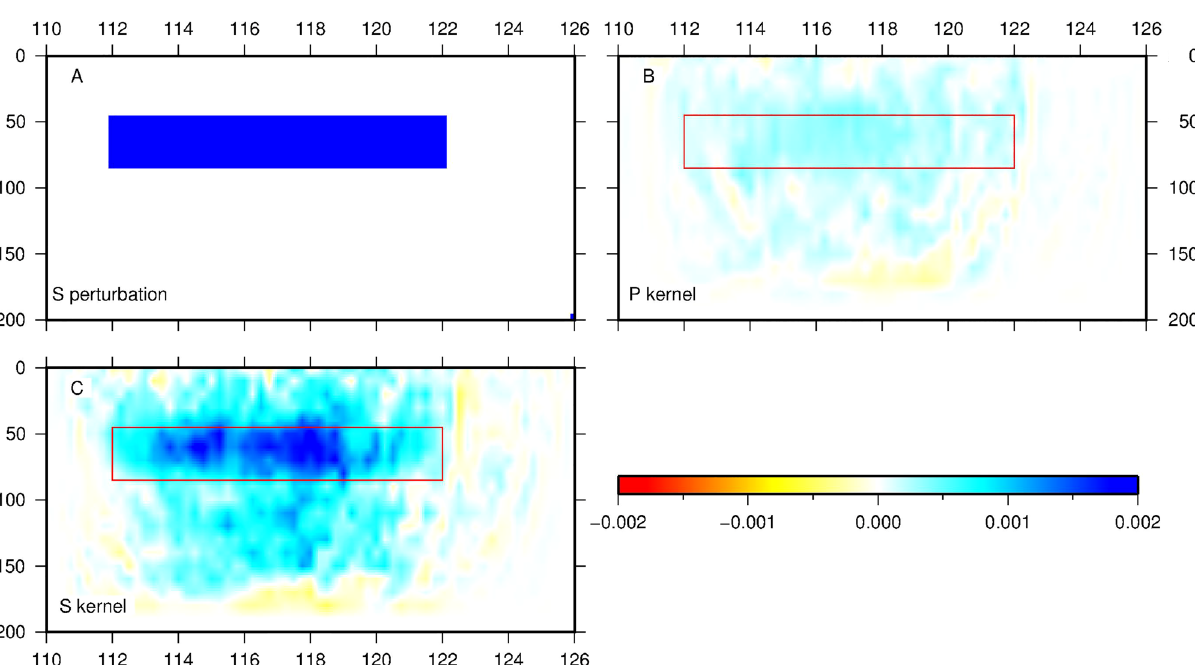
Figure 4. Sensitivity test of Shear wave in the uppermost mantle along 37° N between the depth of 45 km and 85 km. ( a ) input high Shear velocity perturbation, ( b ) sensitivity kernel of P wave, ( c ) sensitivity kernel of S wave. The unit of the color bar is 1 × 10 –10 s 2 m -4 . The map in the figure was generated by the Generic Mapping Tools package 115 (GMT-4.5.9, https:// www. gener ic- mappi ng- tools.